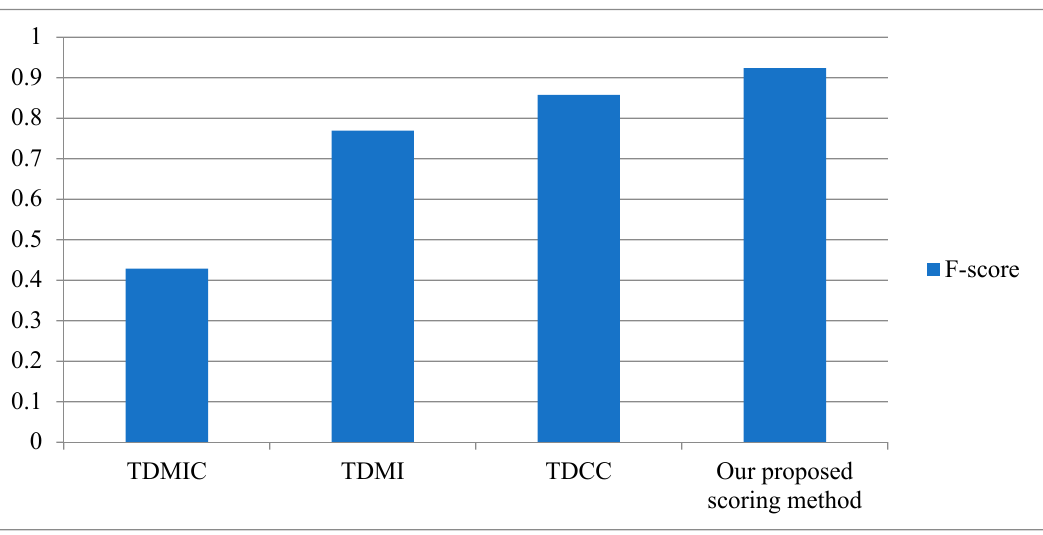
Figure 13. F-score results of four reducing redundancy methods.